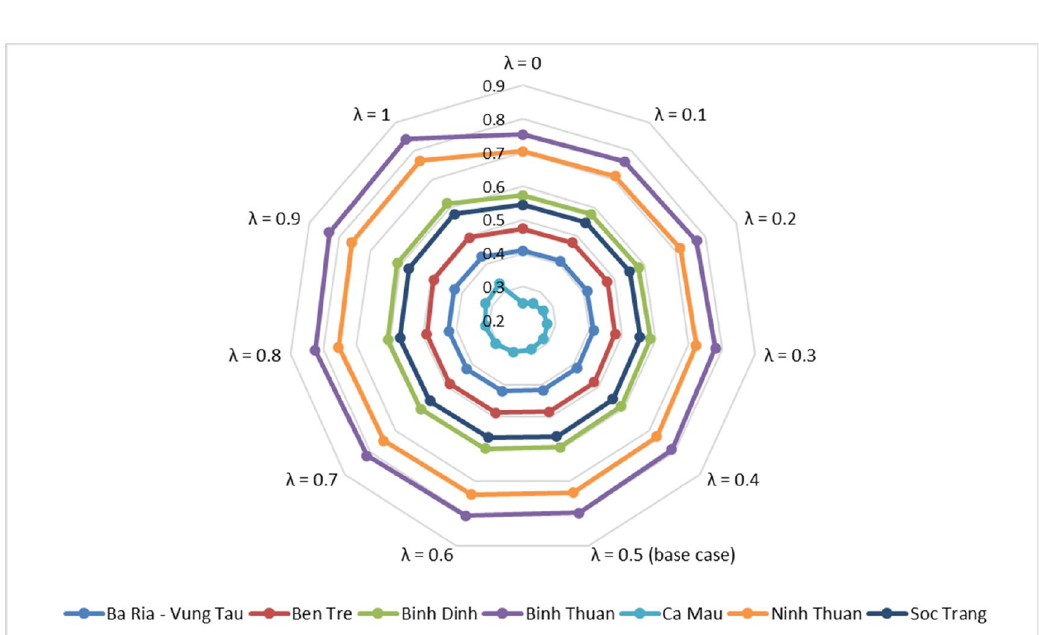
Figure 7. Sensitivity analysis of the threshold value of the WASPAS